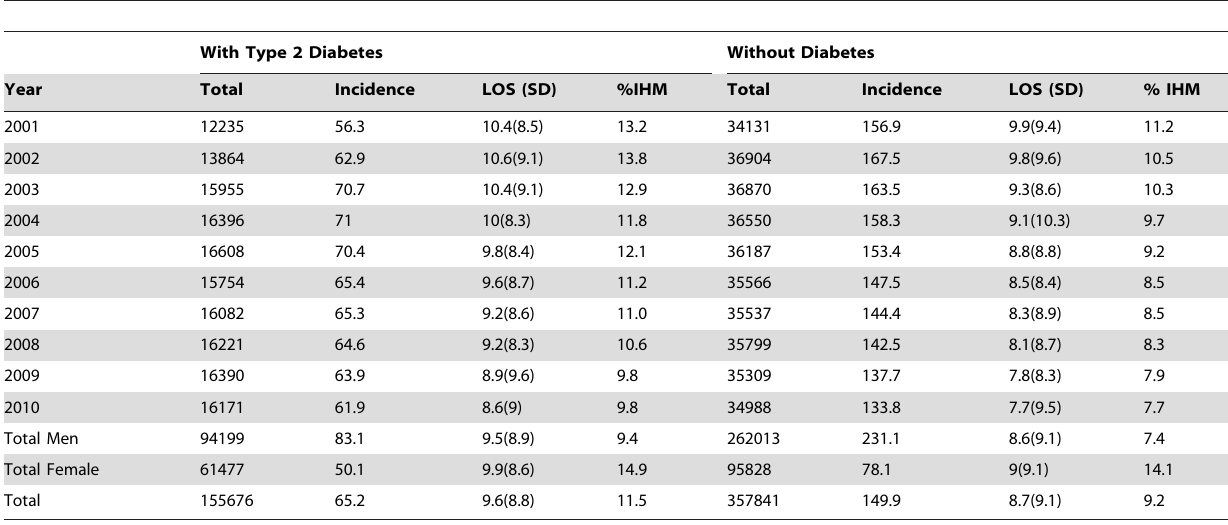
Table 1. Hospital discharges due to acute myocardial infarction among patients with and without type 2 diabetes in Spain, 2001– 2010.